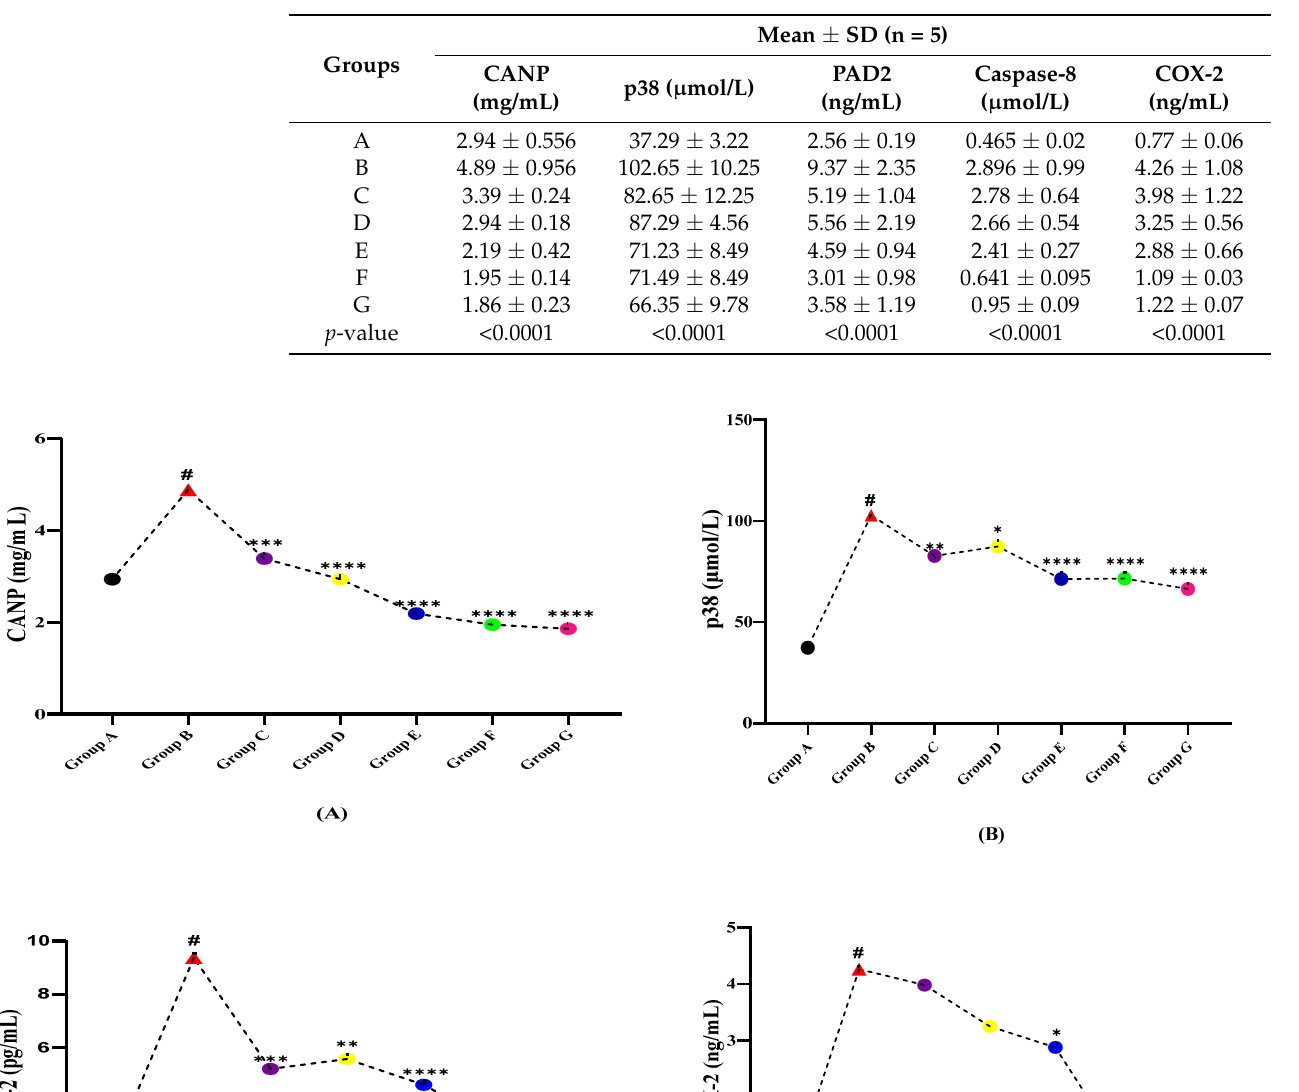
Table 5. Signaling Profile Of LPS Induced Multiple Sclerotic Wistar Rats.